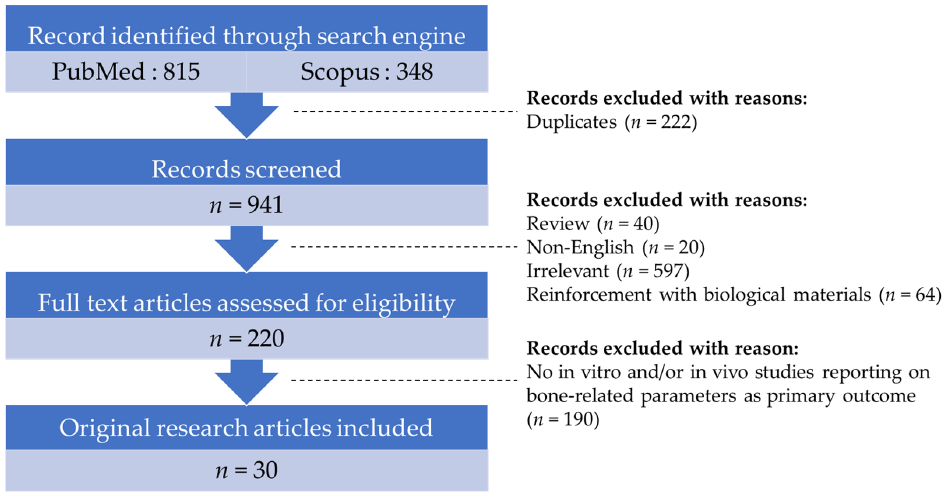
Figure 2. Evidence collection